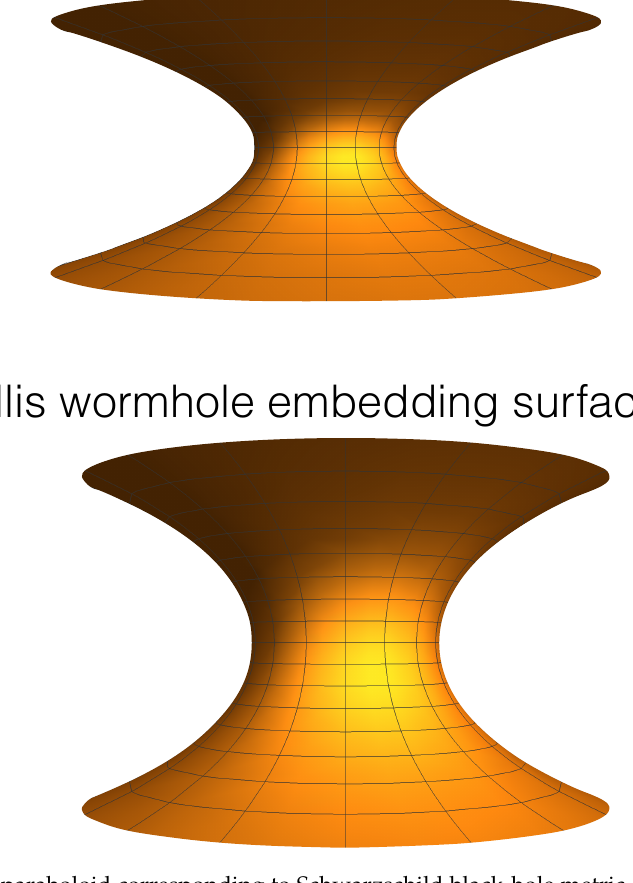
Figure 1. ( a ) Flamm paraboloid corresponding to Schwarzschild black-hole metric. ( b ) Embedding surface of Ellis traversable-wormhole metric. Schwarzschild radius in ( a ) is equal to wormhole’s throat radius in ( b ) b 0 = 30 µ m. Notice the similarity between both figures. ( b ) does not seem to entail additional experimental